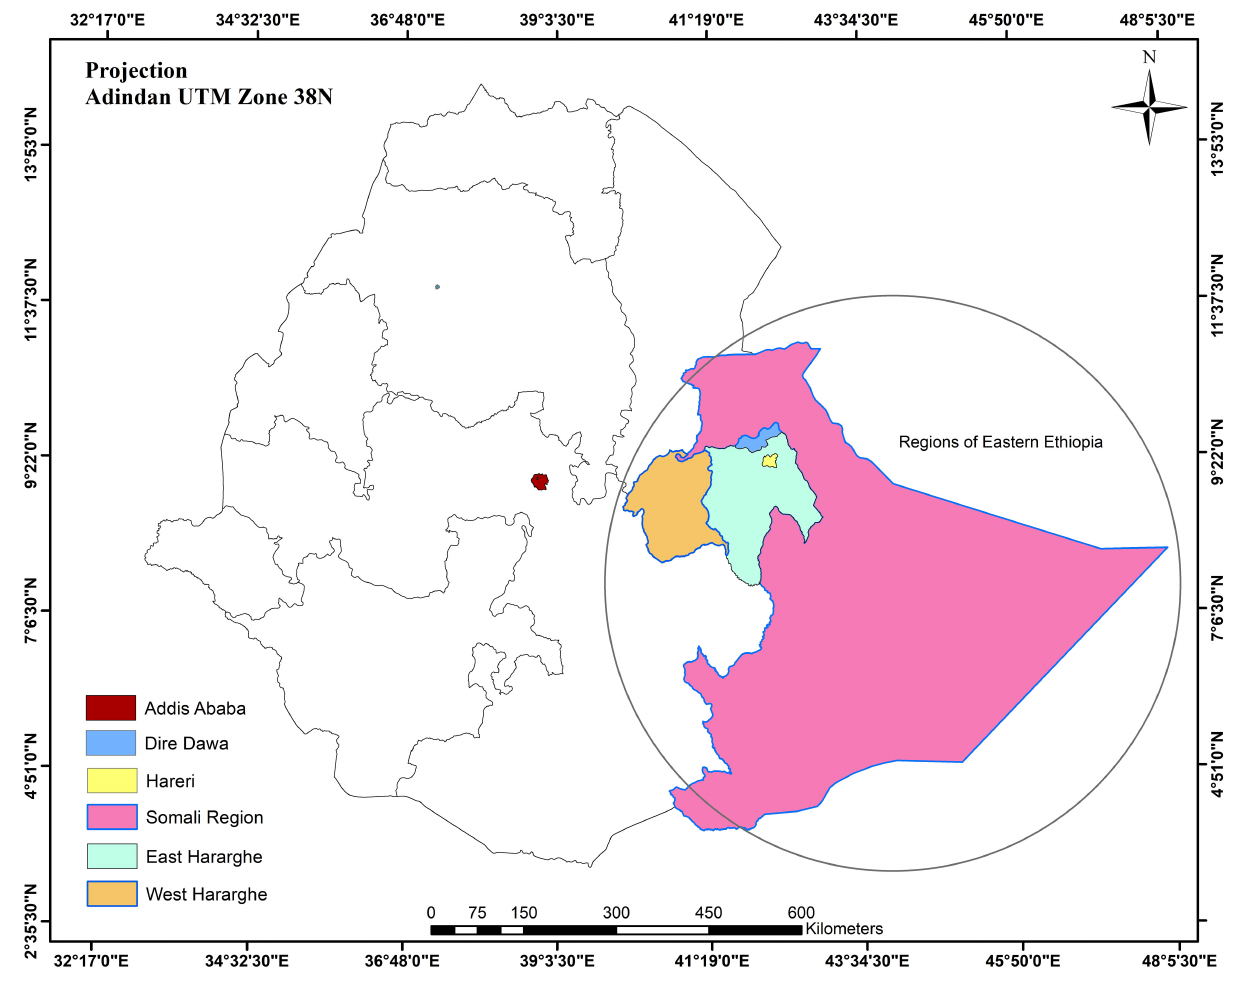
FIGURE 1 | Ethiopia regions, Eastern Ethiopia, including Somali, Dire Dawa, Harari, and Eastern and Western Hararghe